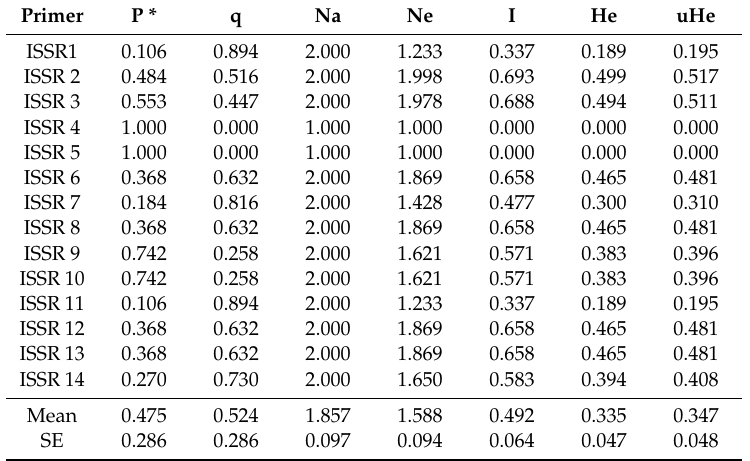
Table 10. Genetic diversity of 15 accessions of S. italica assessed by ISSR markers.